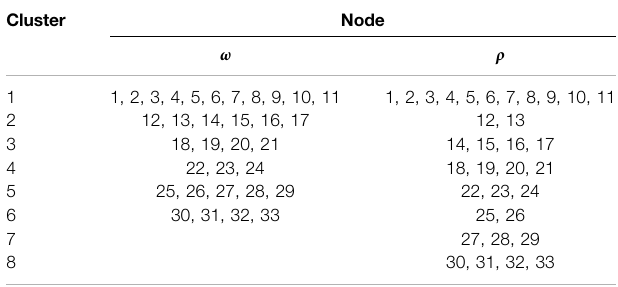
TABLE 4 | Results of cluster partition under different